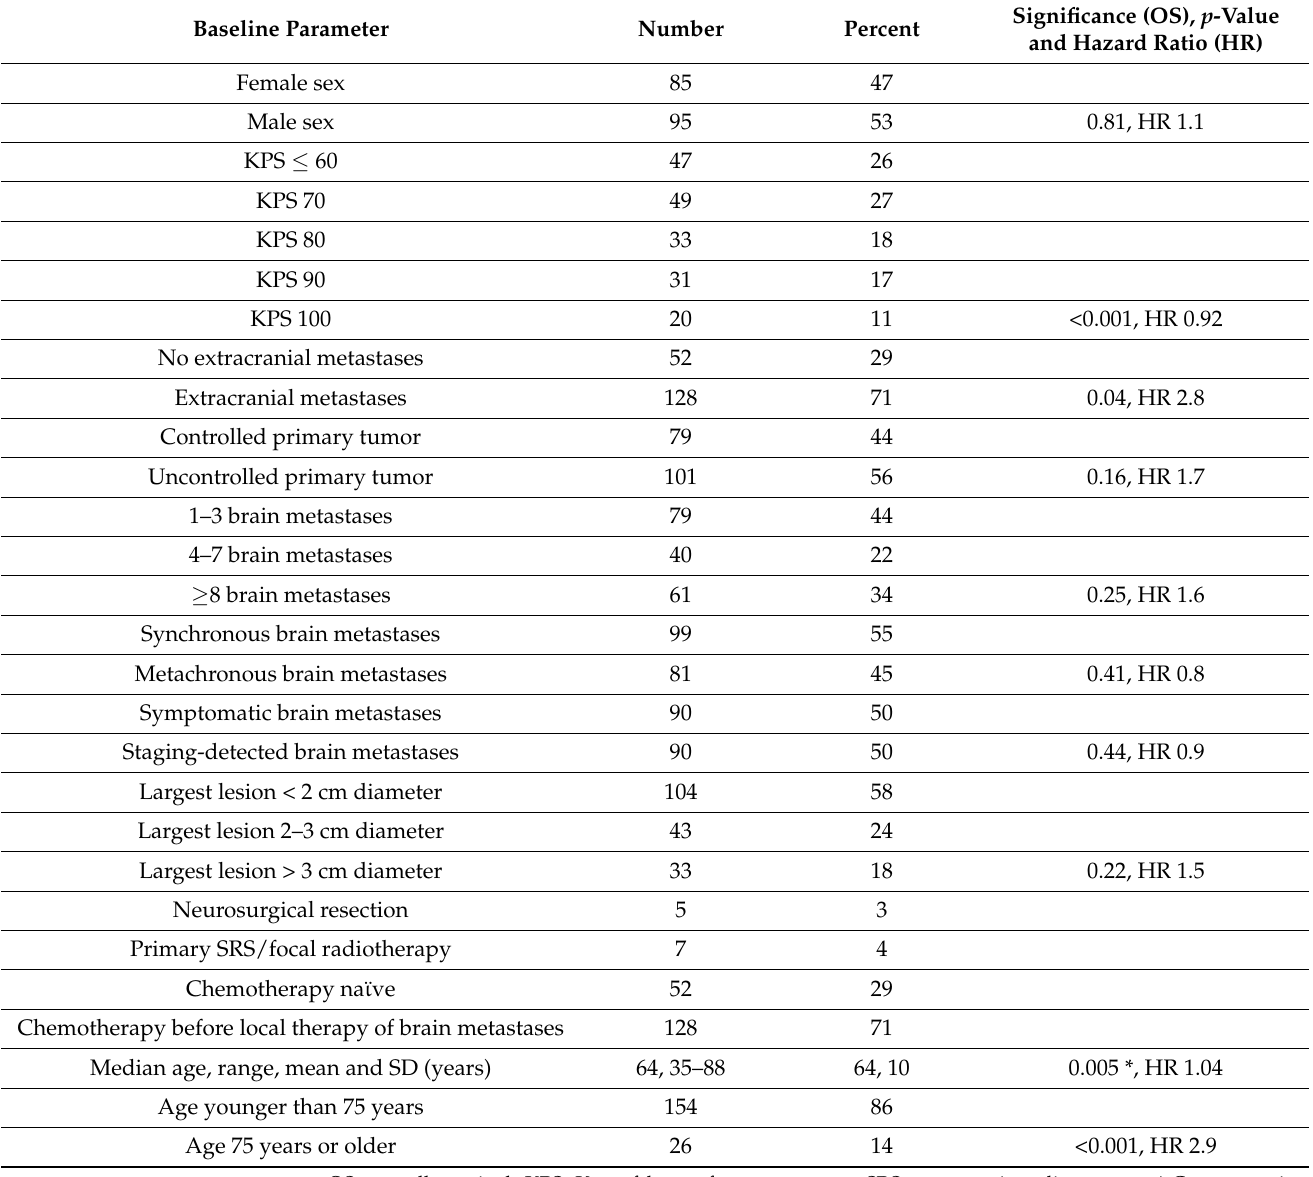
Table 2. Patient characteristics ( n =